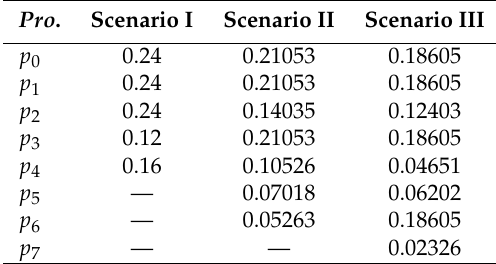
Figure 13. The reachable graph for Scenario I. Table 8. The steady state probability of Scenarios